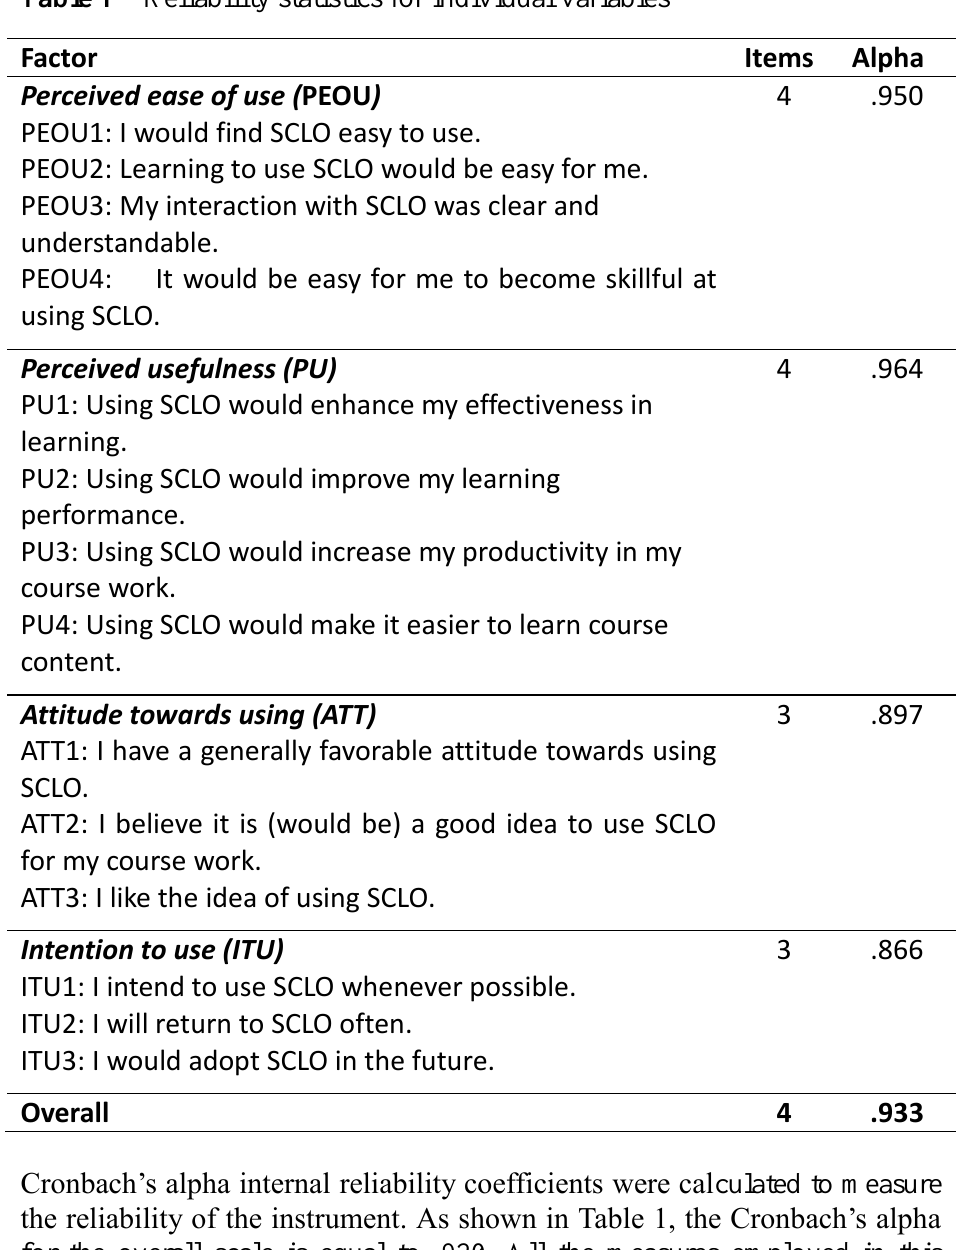
Table 1 Reliability statistics for individual